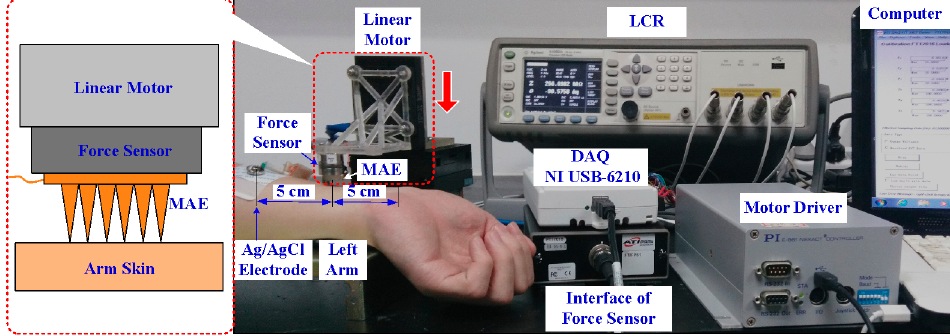
Figure 3. Setup for EII recording during the insertion process.